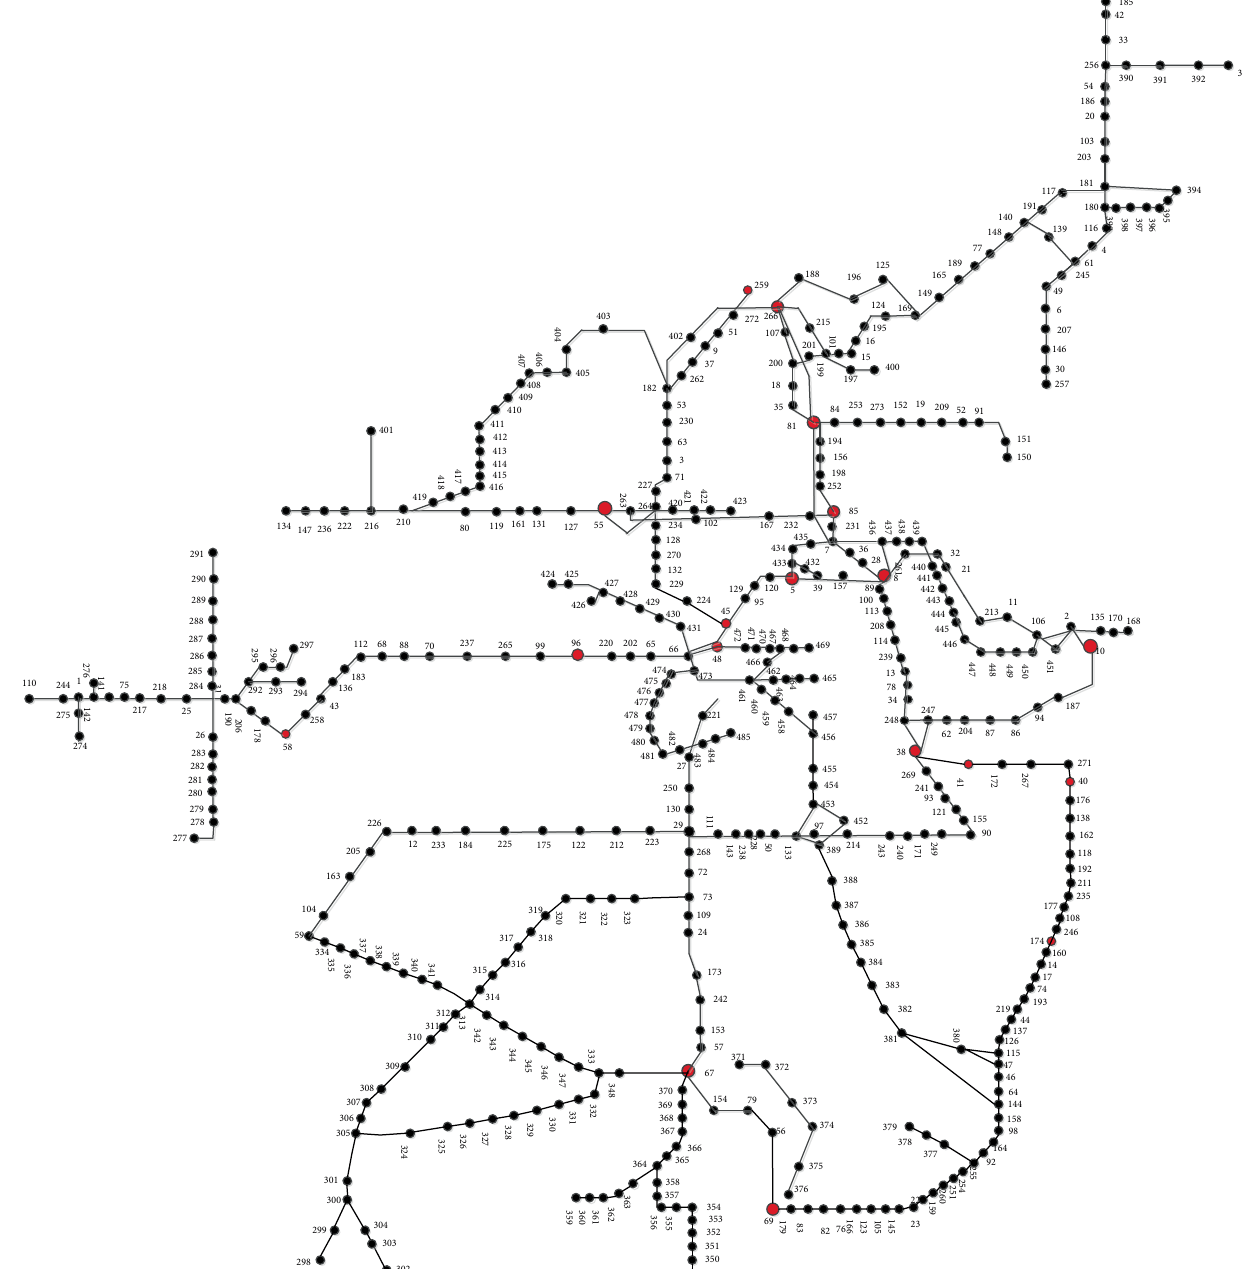
Figure 5: High-speed railway physical network in